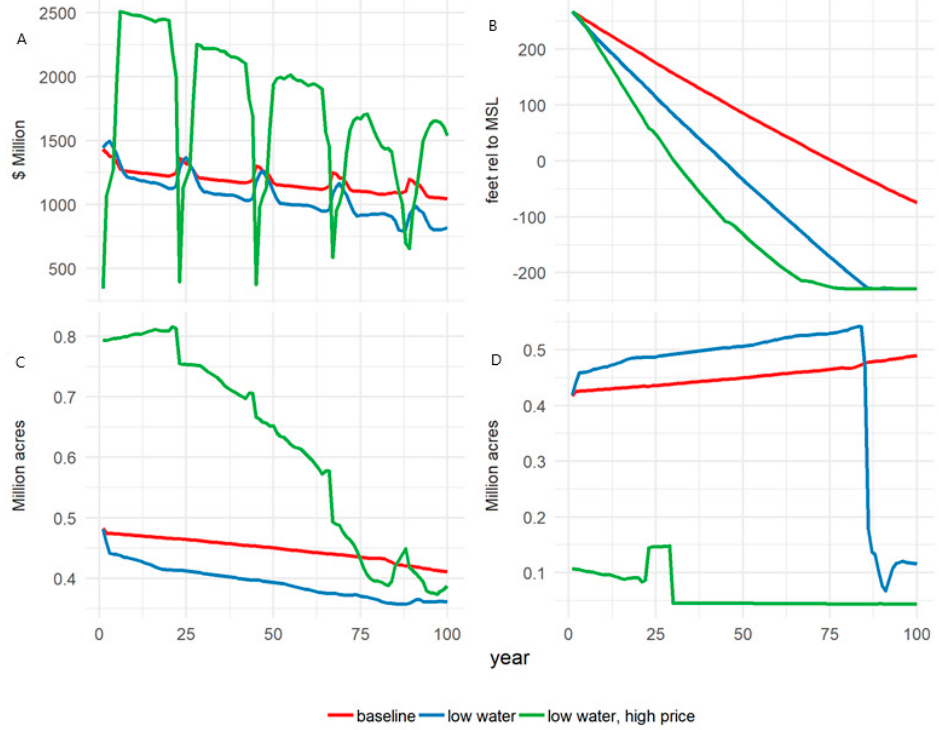
Figure 4. Key time series for “baseline”, “low water”, and “low water, high price” scenarios. ( A ) annual net benefits, ( B ) aquifer height, ( C ) perennial area, and ( D ) annual area.